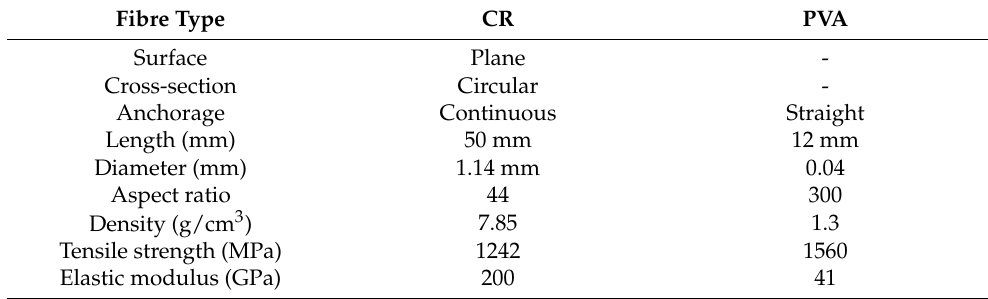
Table 3. Properties of used fibres.